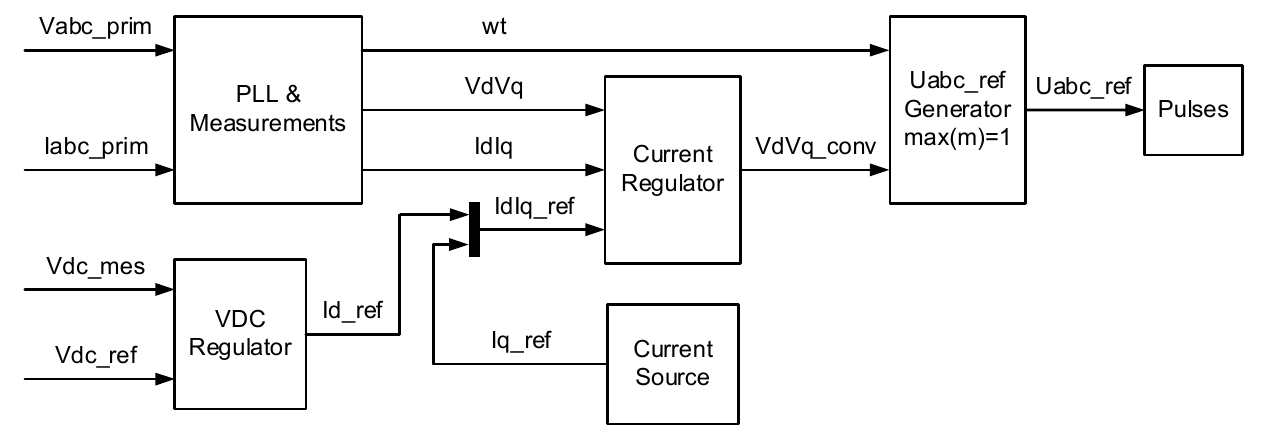
Figure 9. Diagram of the VSC inverter implemented in Matlab/Simulink.